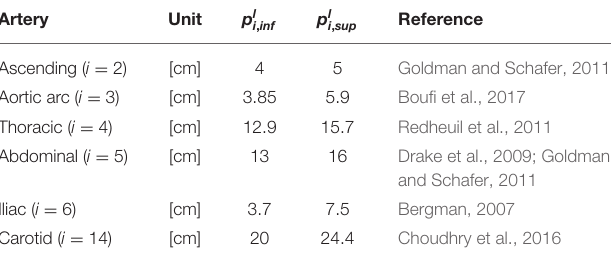
TABLE 5 | Summary of the ranges for the arterial lengths utilized in this study.